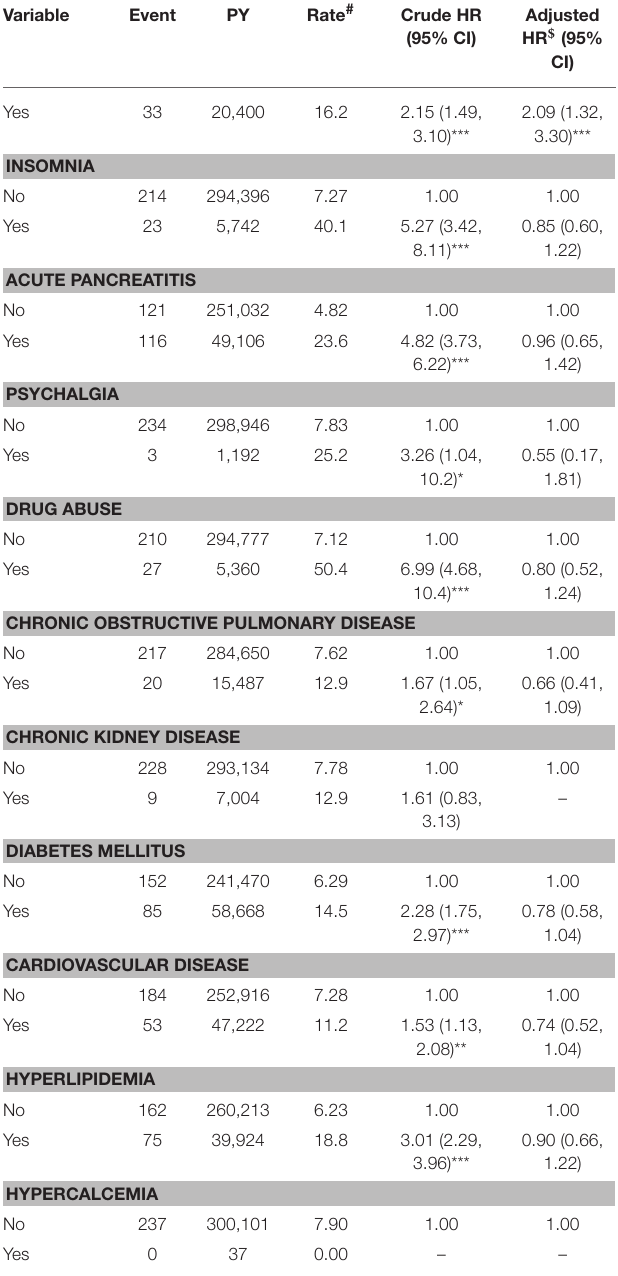
Table 6 indicates that the suicide-related fatality